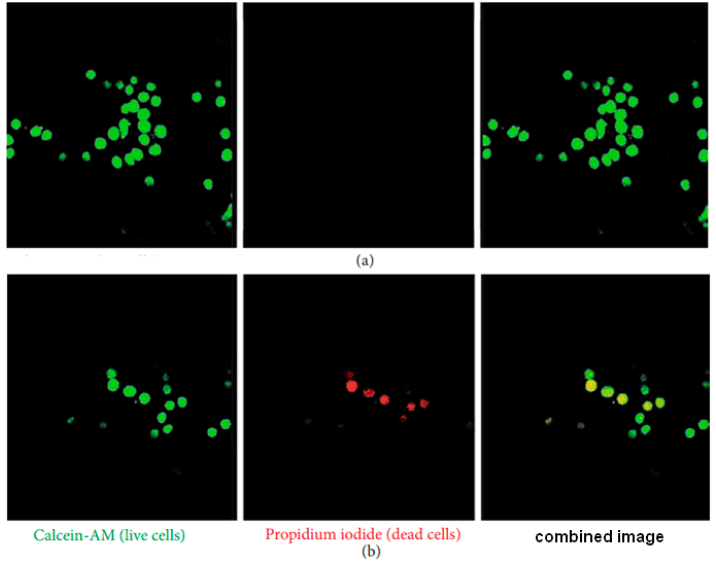
Figure 9. Fluorescence microscopic images of calcein-AM (green) and propidium iodide (red) staining of differentiated macrophages on ( a ) TiO 2 /HA, and ( b ) TiO 2 /HA-P scaffolds after seeding for three days (magnification: ×200) Ref. [36].